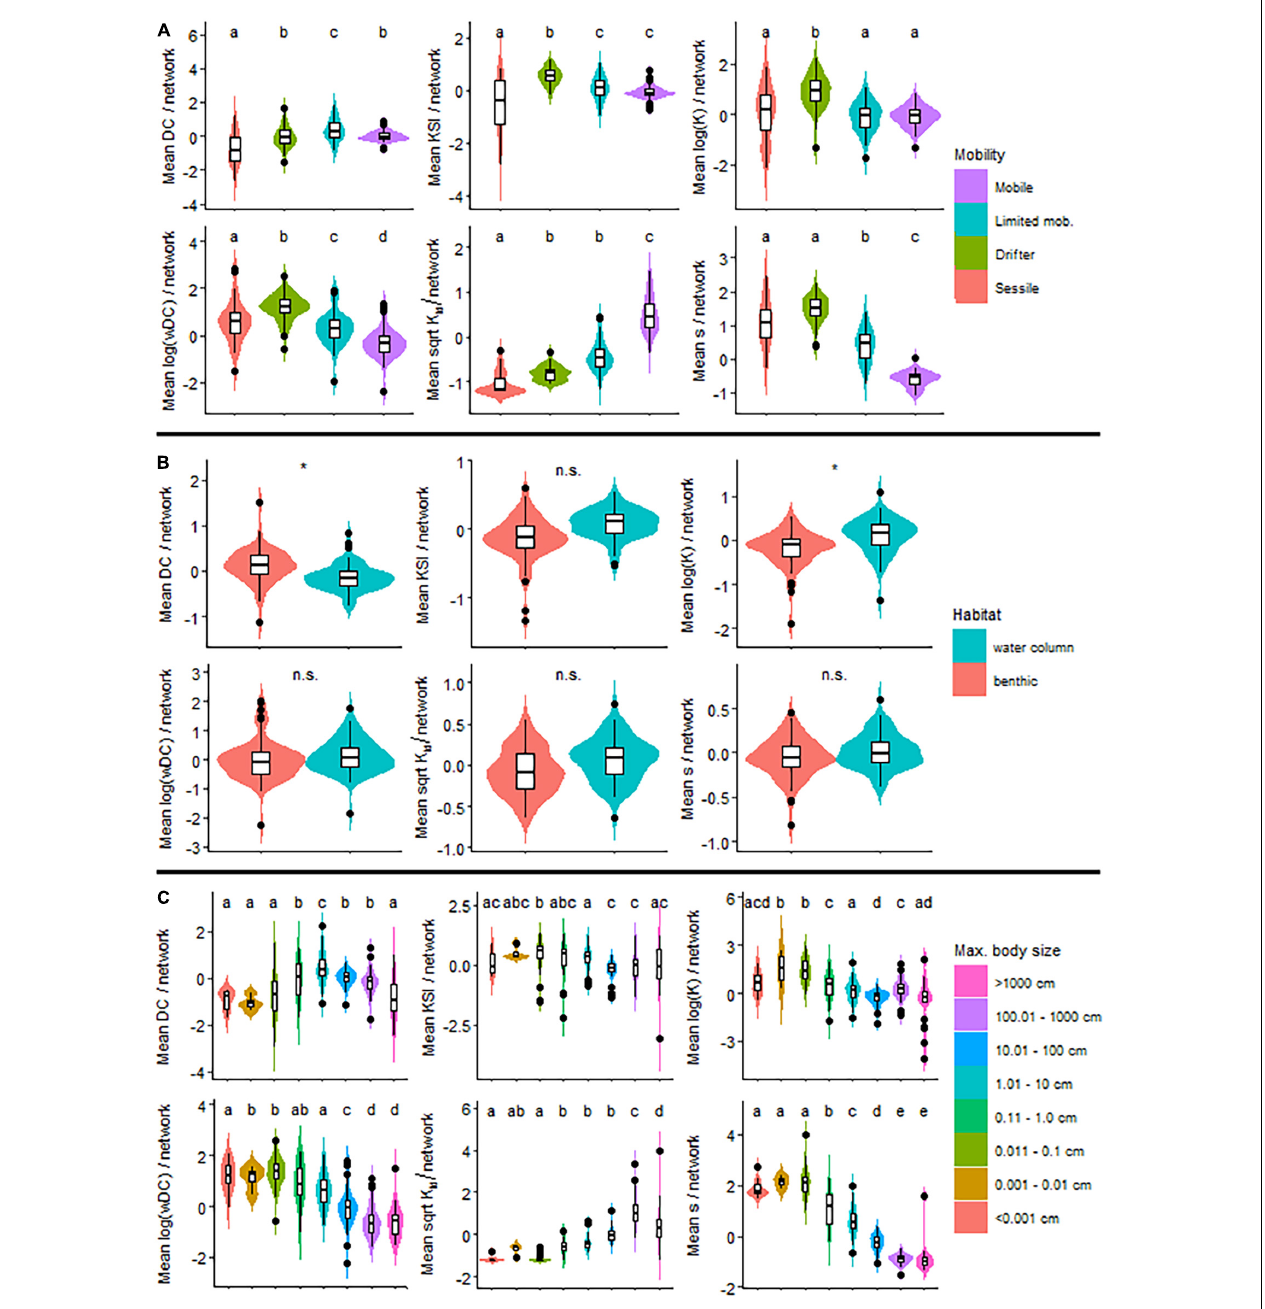
FIGURE 4 | The distribution of index values for trait categories. One representative index (DC, KSI, logK, logwDC, sqrtK td , and s) is used for each of the six clusters in the dendrogram on Figure 1 . Traits are mobility (A) , habitat (B) , and size (C) . * indicates significant difference between habitat categories. For each of the 18 indices, separately, see the same information in Supplementary Material D